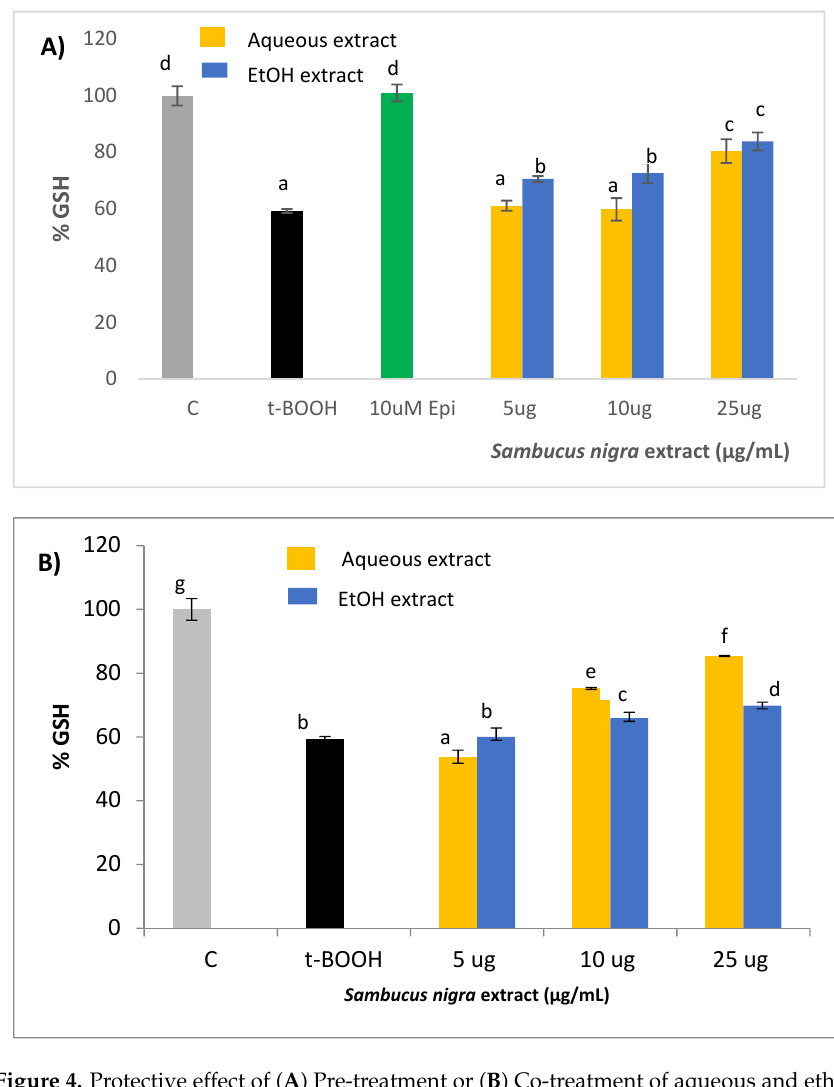
Figure 4. Protective effect of ( A ) Pre-treatment or ( B ) Co-treatment of aqueous and ethanolic extracts from S. nigra flowers on GSH levels of SH-SY5Y cells. Values are means ± SD, n = 4. Values are expressed as a percent relative to activity of control condition. Different letters indicate statistically significant differences ( p < 0.05) among groups.